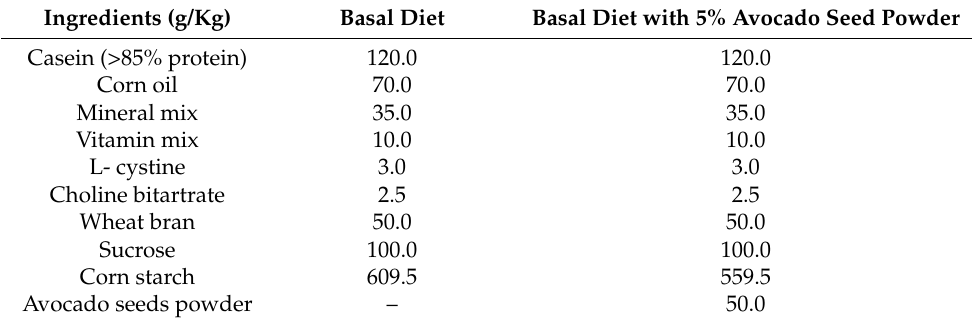
Table 1. Formulations of the diets—basal or supplemented with 5% avocado seed